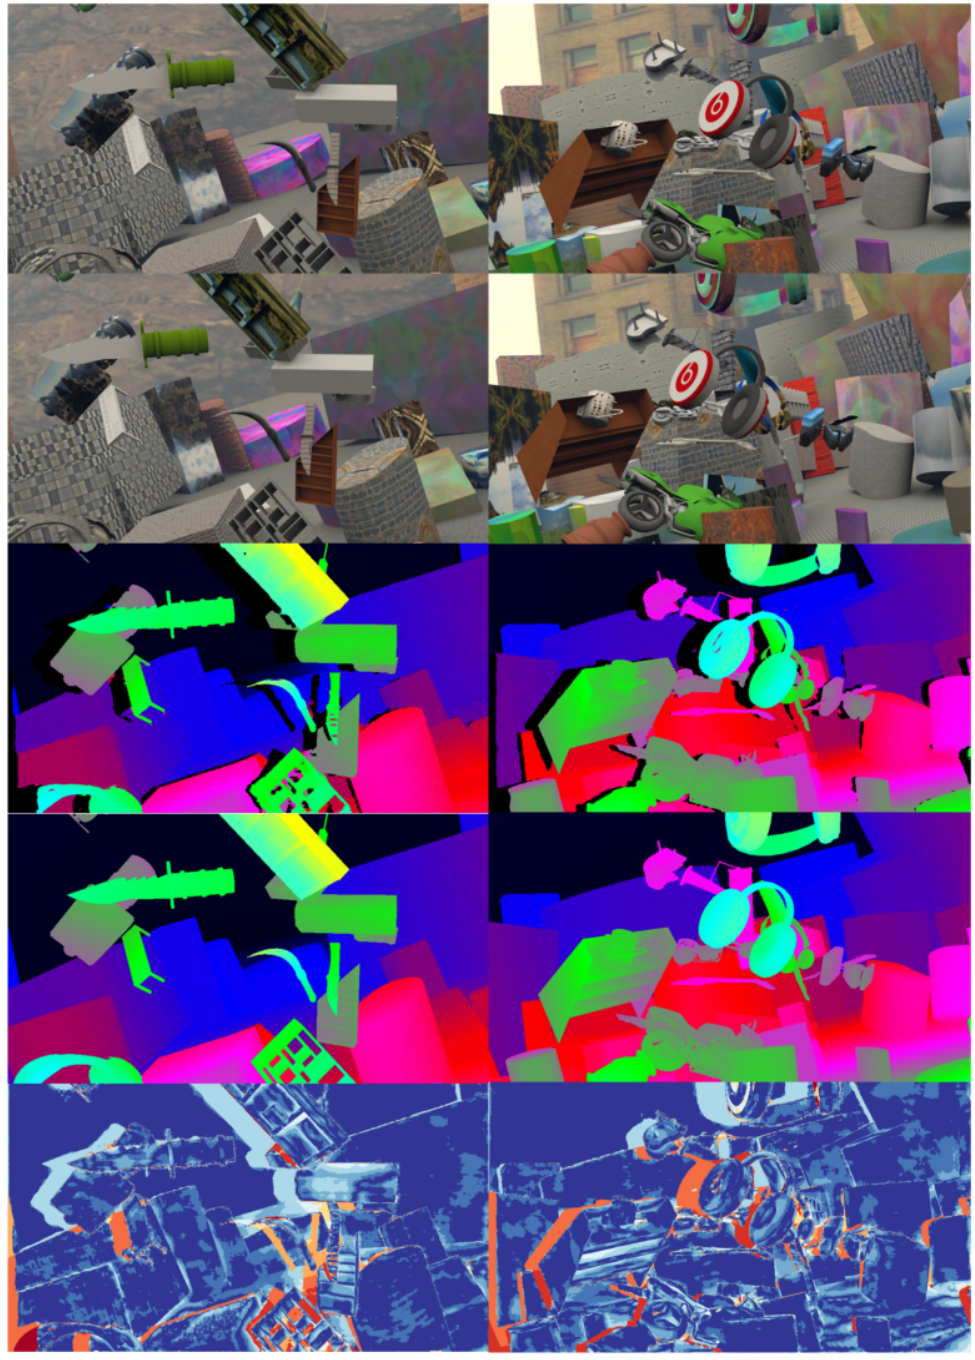
Figure 13. Splitting the default training and testing sets of DispNet/FlowNet2.0 for